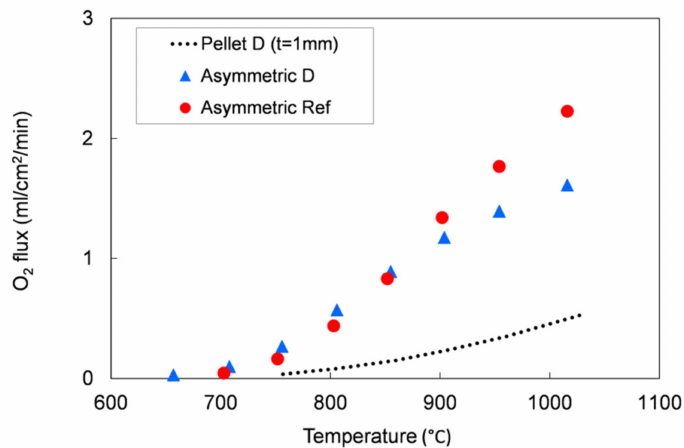
Figure 13. Oxygen flux as a function of the temperature. Results of permeation tests performed on an asymmetric membrane manufactured with the reference powder and on a pellet and an asymmetric membrane manufactured with the Praxair powder (D) selected in this